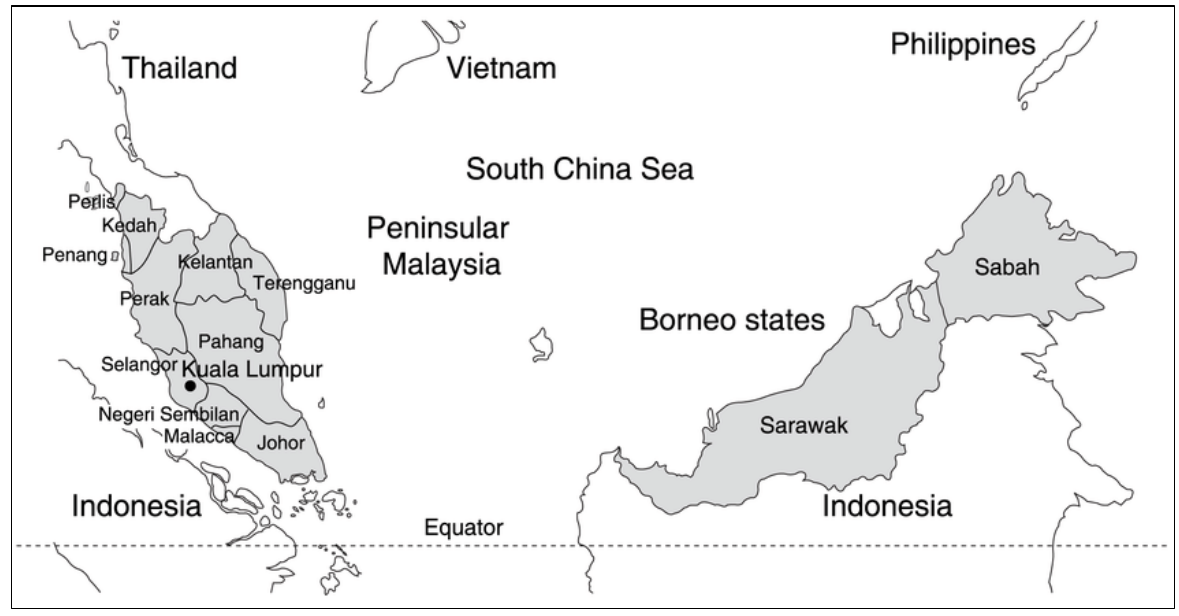
Figure 1. Map of Malaysia showing all states and federal territories.